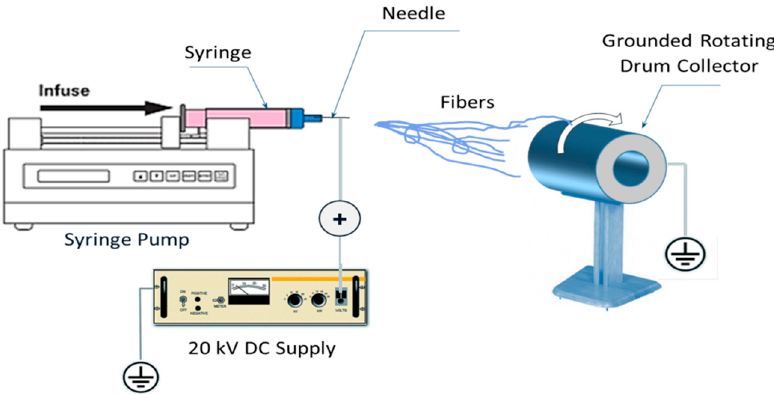
Figure 1. Schematic diagram of the electrospinning process.